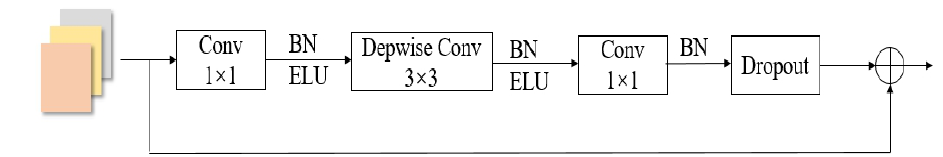
Figure 4. MBConv structure.